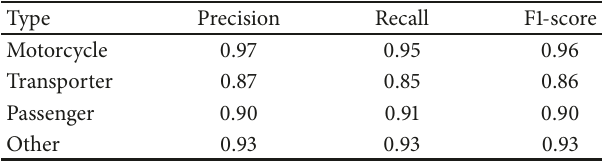
Table 3: Classification precision, recall, and f1-score of CNNs. Type